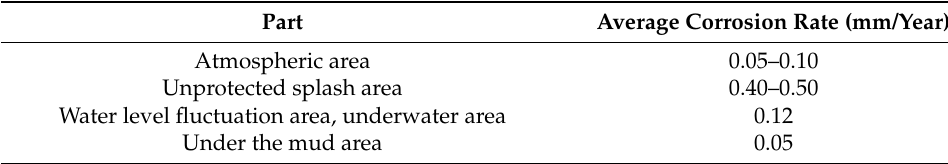
Table 2. Average corrosion rate of the steel structure.